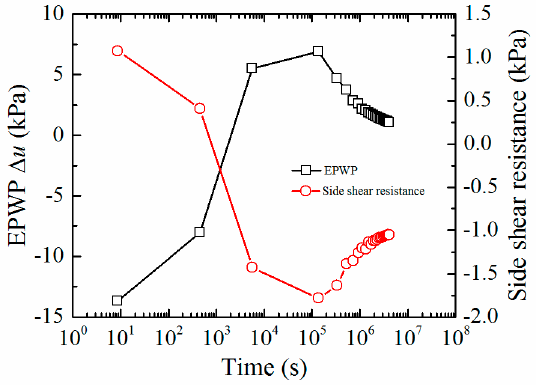
Figure 20. Comparison between the dissipation of EPWP and pile set-up at depth of 1.4 m after pile installation.